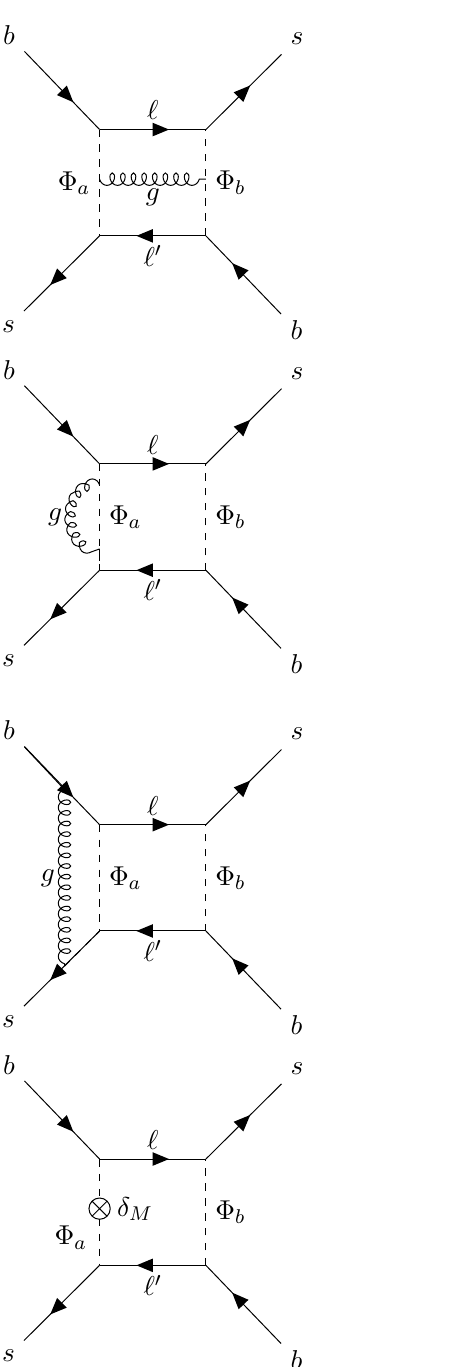
Figure 3 . A sample of two-loop diagrams, and one-loop diagrams with counterterm insertions (indicated by the cross), contributing to the NLO QCD matching for B s − ¯ B s